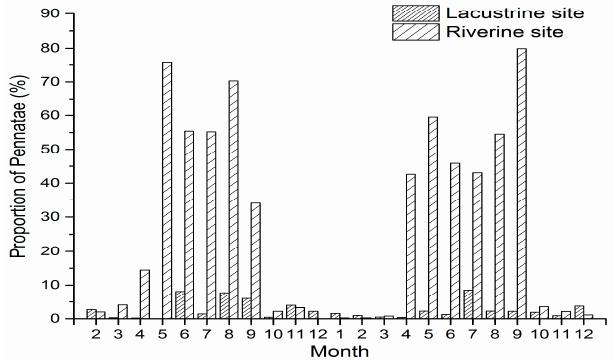
Figure 7. Monthly variation of pennate diatoms in the lacustrine zone and the riverine